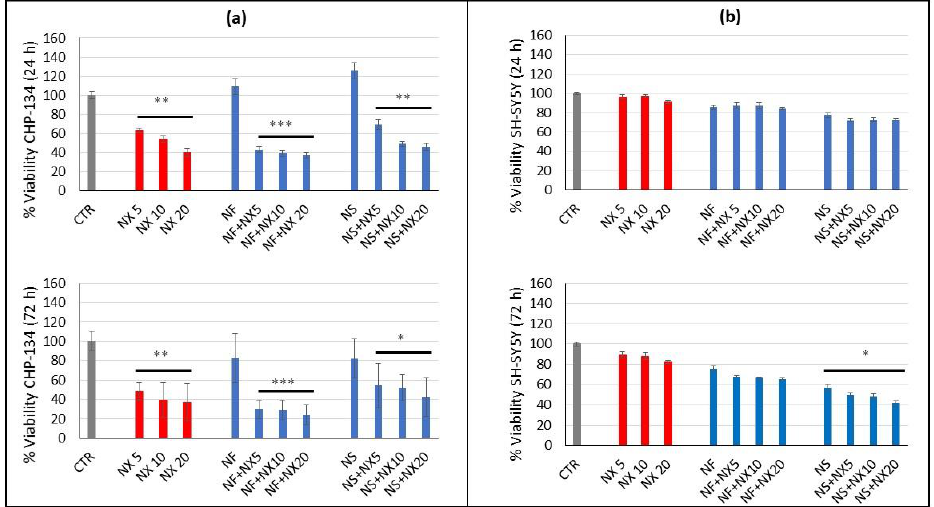
Figure 4. Relative viability of ( a ) CHP-134 and ( b ) SH-SY5Y cells treated with naxitamab at 5, 10, and 20 ug/mL and naxitamab in combination with 0.05 mg/mL Nanofenretinide (NF) or Nanospermidine (NS) for 24 h or 72 h. Viability was evaluated by MTT assay and expressed as percentage versus control (100%) (mean ± SD, n = 6) (* p < 0.05, ** p < 0.01, and *** p < 0.001). These results are supported by the fluorescence microscopy images of CHP-134 showing an improvement of cell death by treatments with NF plus NX, but not with NS plus NX, with respect to the sole NX (Figure 5a). Moreover, treatments with empty na- nomicelles plus NX did not show any difference with respect to the single NX treatment, thus indicating a lack of activity of the empty nanomicelles.